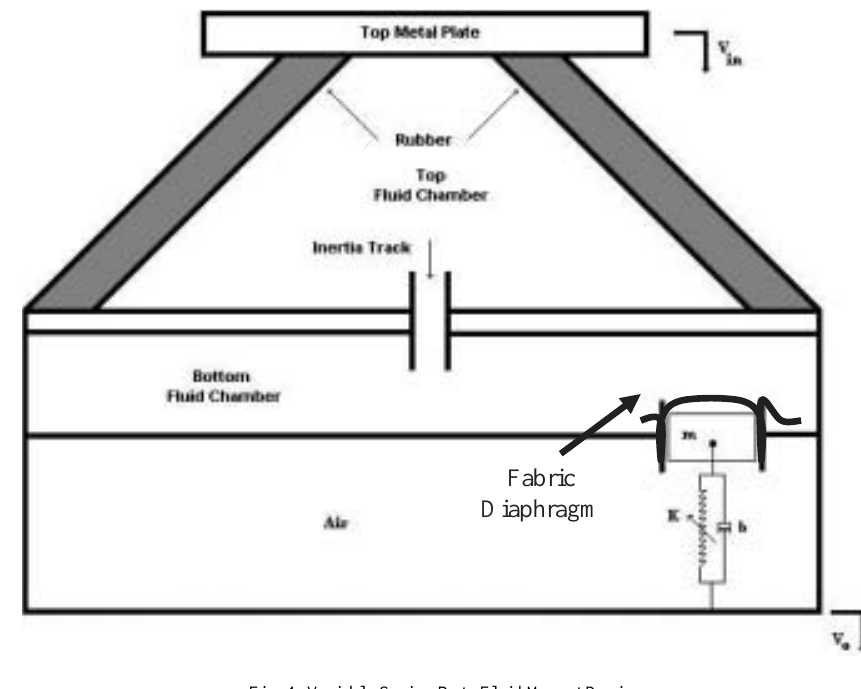
Fig. 4. Variable Spring Rate Fluid Mount Design.